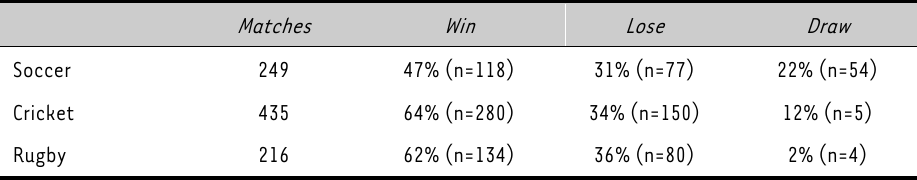
Summary of match outcomes according to sporting